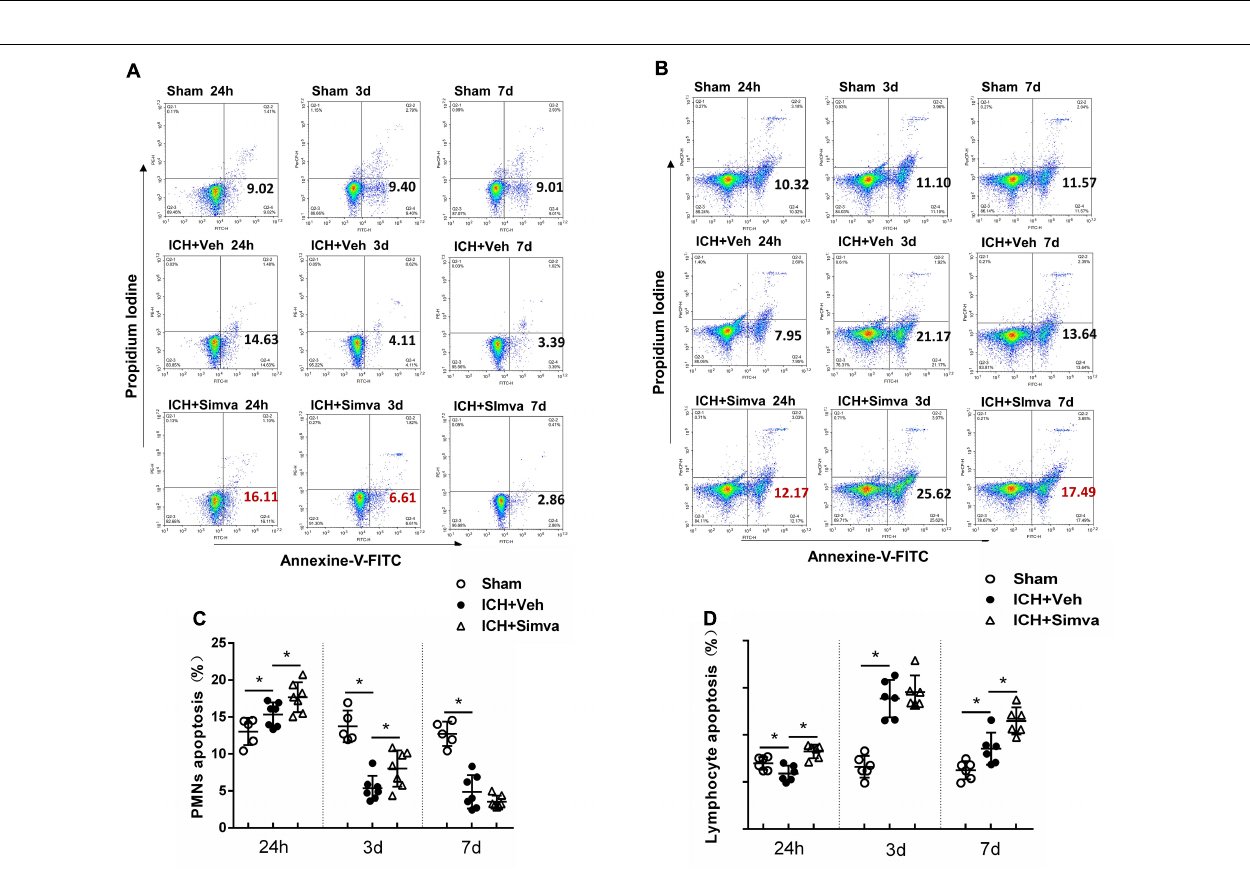
FIGURE 5 | Simvastatin accelerated peripheral PMNs apoptosis after ICH, which in part by broke the balance between antiapoptotic proteins and proapoptotic proteins. Representative flow cytometric dot plots showing circulating PMNs (A) and lymphocytes (B) apoptosis, which freshly isolated from sham control rat and ICH rat treated with vehicle or simvastatin. Annexin V+ and PI − cells were considered early apoptotic cells (lower right quadrant). Flow cytometric analysis of peripheral PMNs (C) and lymphocytes (D) in the simvastatin- and vehicle-treated rat days 1, 3, and 7 after ICH. The apoptotic ratio was calculated from the ratio of apoptotic cells to total cells counted. Values are expressed as mean ± SD, n = 6 per group; ∗ P < 0.05.